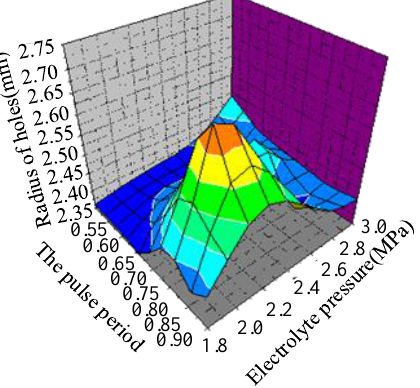
Figure 15. Response surface diagram of the entrance diameter.